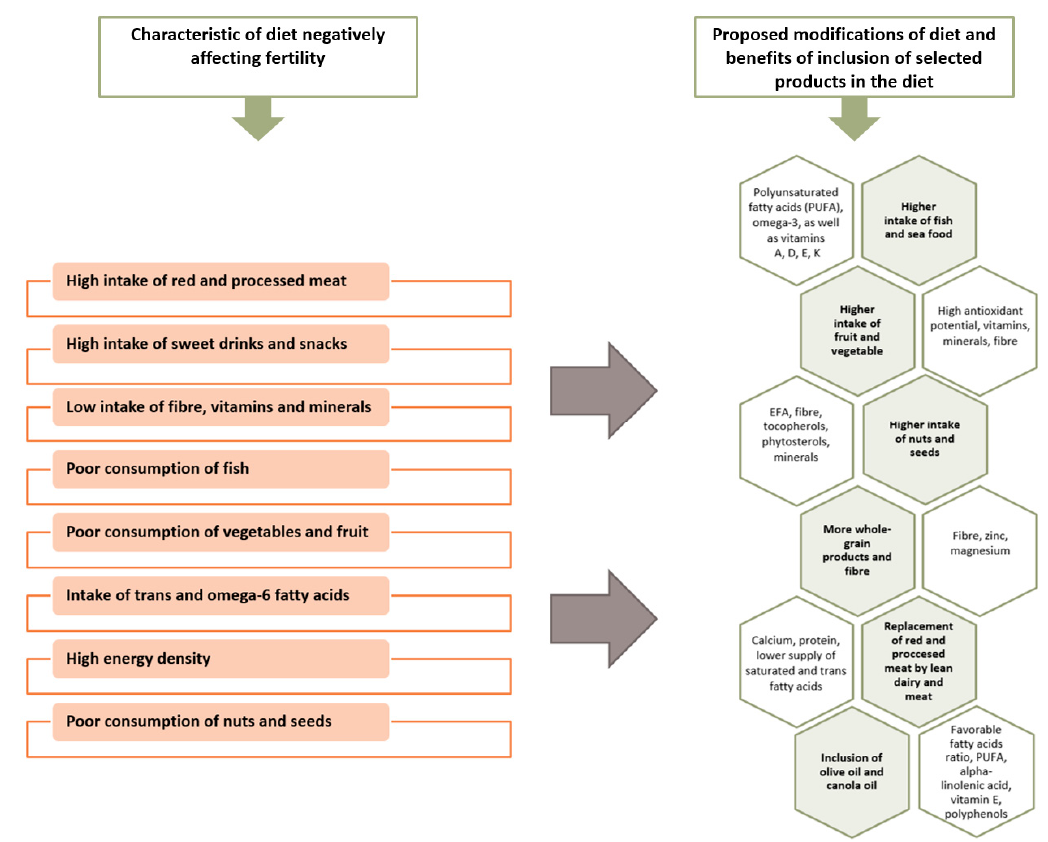
Figure 1. Characteristics of a diet negatively affecting fertility and its proposed modifications. [6,7,31].